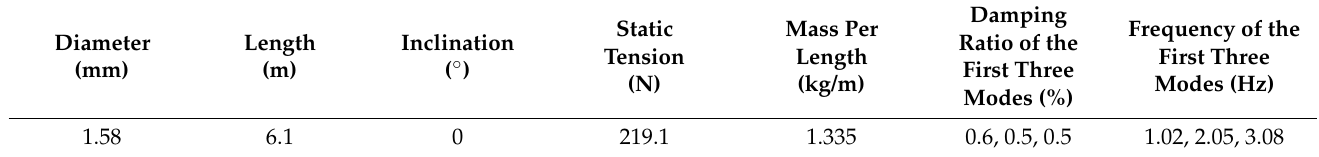
Table 1. The main parameters of the scaled cable.